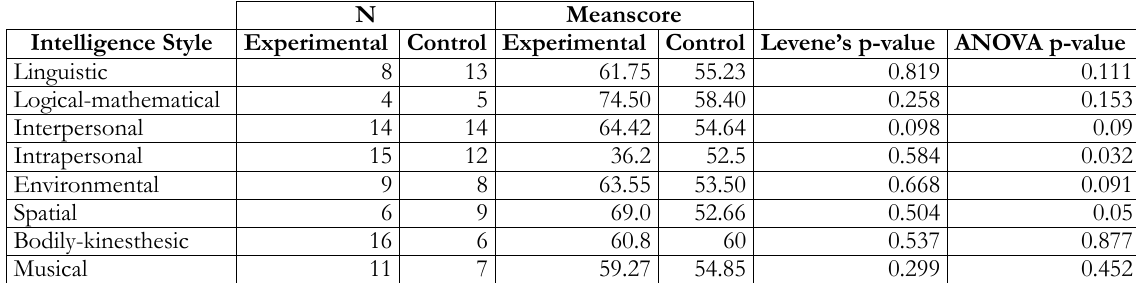
Table 2. Emotional ANOVA post-test results segmented by Intelligence